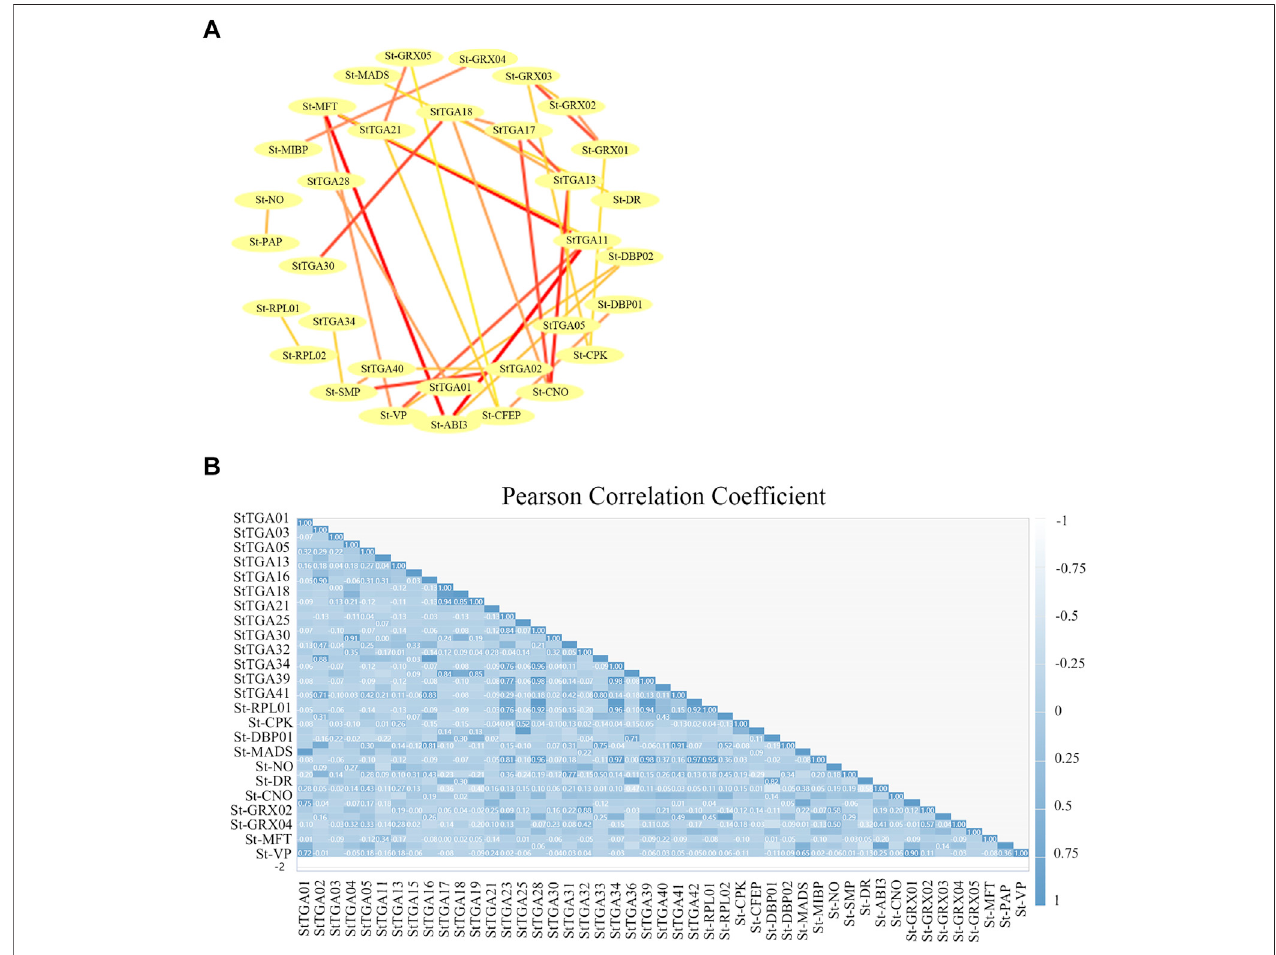
FIGURE 6 | Construction of the StTGA co-expression network. (A) Co-expression network analyses are performed to characterize the 36 differentially expressed StTGA.Inthenetwork,nodesrepresentedRNAs,whilelinesrepresentedco-expressionandpredictionrelationship. (B) PCCofallgenesineachgeneshowinthis fi gure. Pearson correlation matrix between all StTGAs. (positive correlations = dark blue with value, negative correlations = light blue, non-signi fi cant correlations = white).